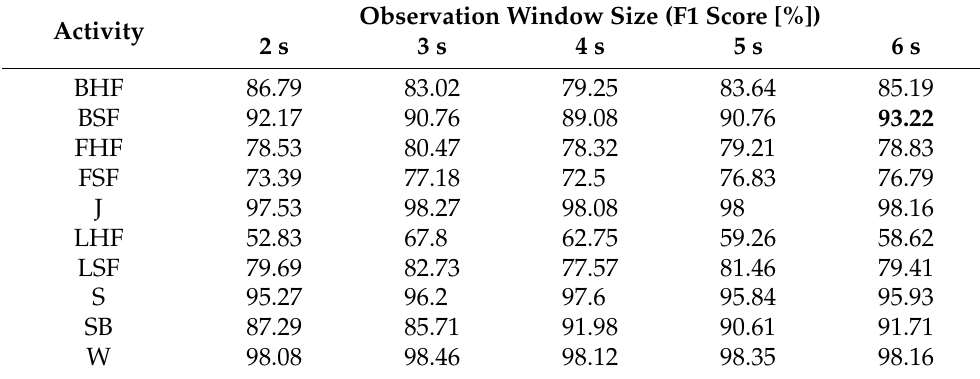
Table 3. Performance for different observation window